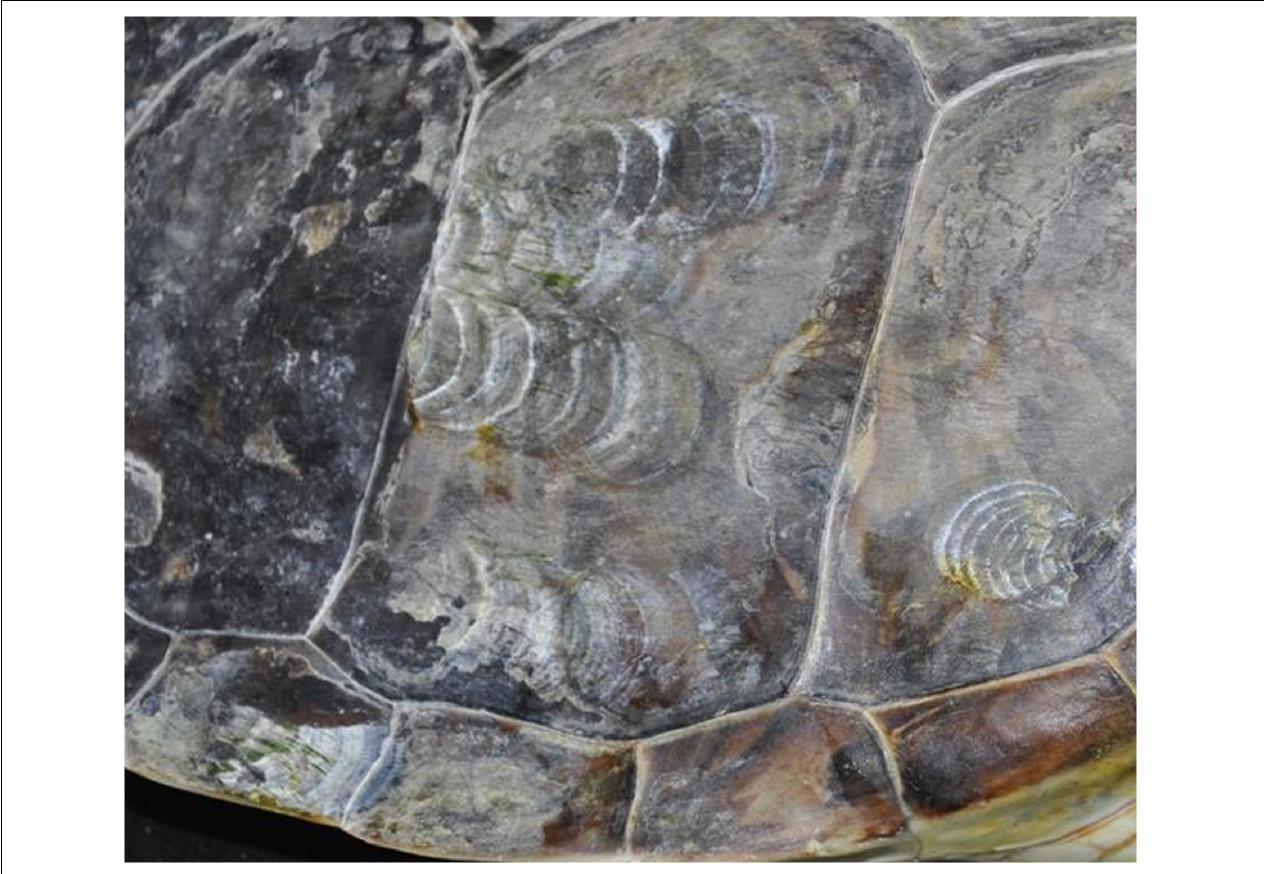
FIGURE 4 | Traces of adhesive cement left by the barnacle Chelonibia testudinaria on the thin carapacial scutes of a green sea turtle, demonstrating the non-destructive attachment and movements of this mobile barnacle (photo made possible by the South Carolina Aquarium, United